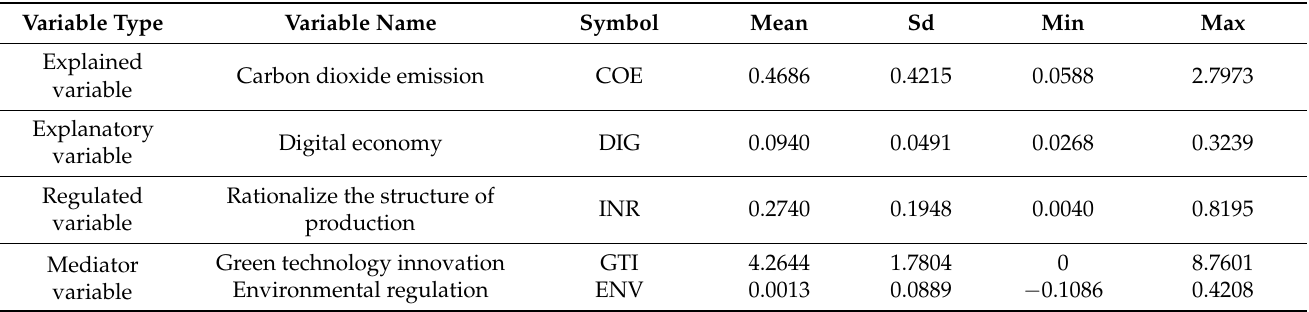
Table 2. Descriptive statistics of